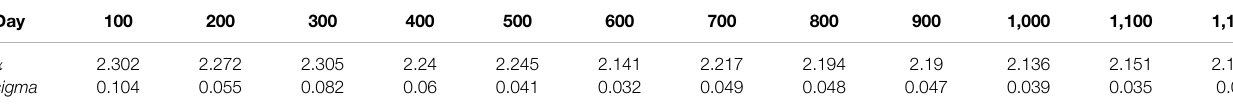
TABLE 1 | Parameters and errors of the fi t.